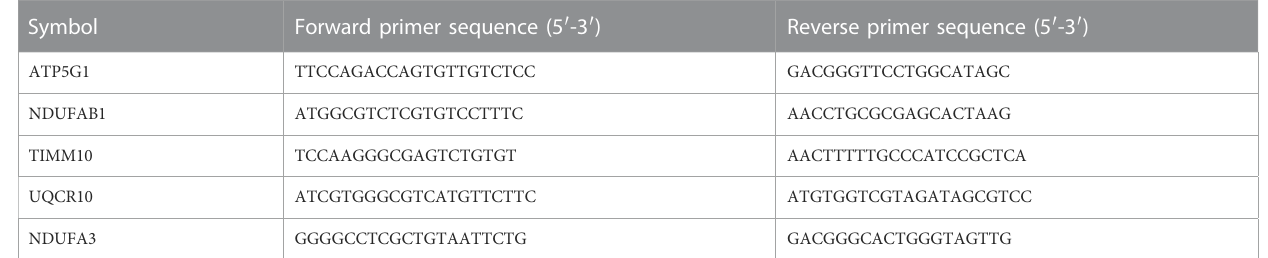
TABLE 1 Primers for quantitative PCR. Symbol